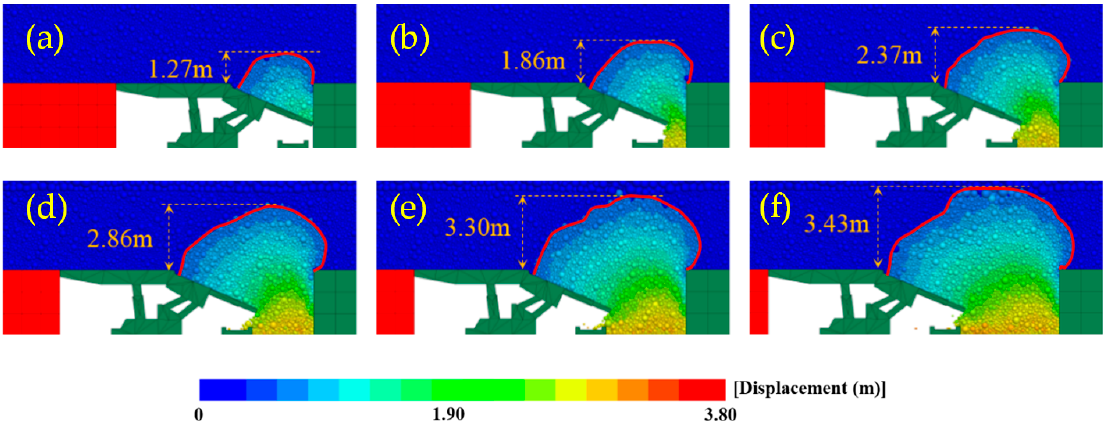
Figure 5. Range of loose body (LB). ( a – f ) respectively refers to the range of LB formed from when the support stays in place to after it is removed for the 5th